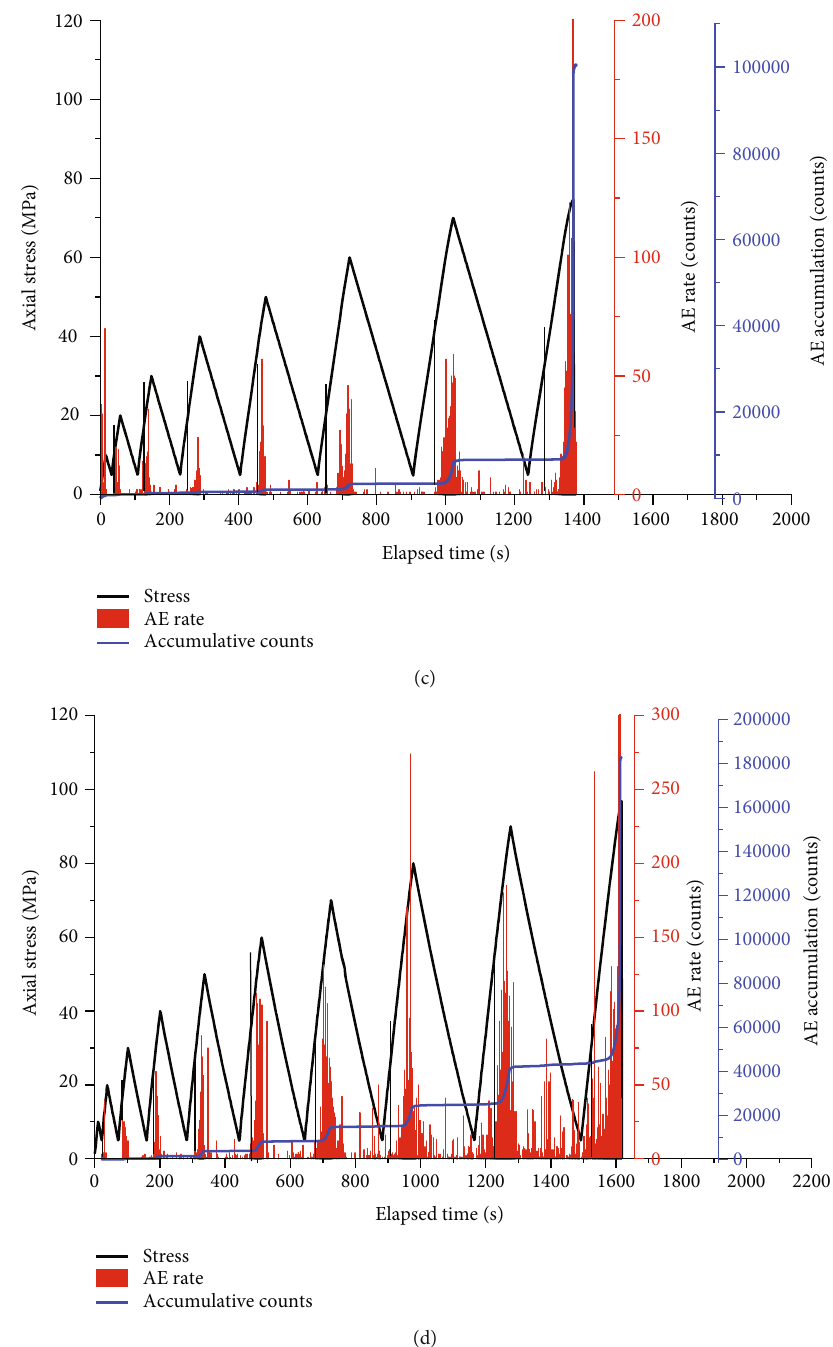
Figure 14: Output of AE counts for the tested granite samples. (a – d) It corresponds to samples of NFG-34, NFG-24, NFG-21, and NFG-30, and the corresponding natural fracture volume ratios are 0.19%, 0.15%, 0.13%, and 0.11%,